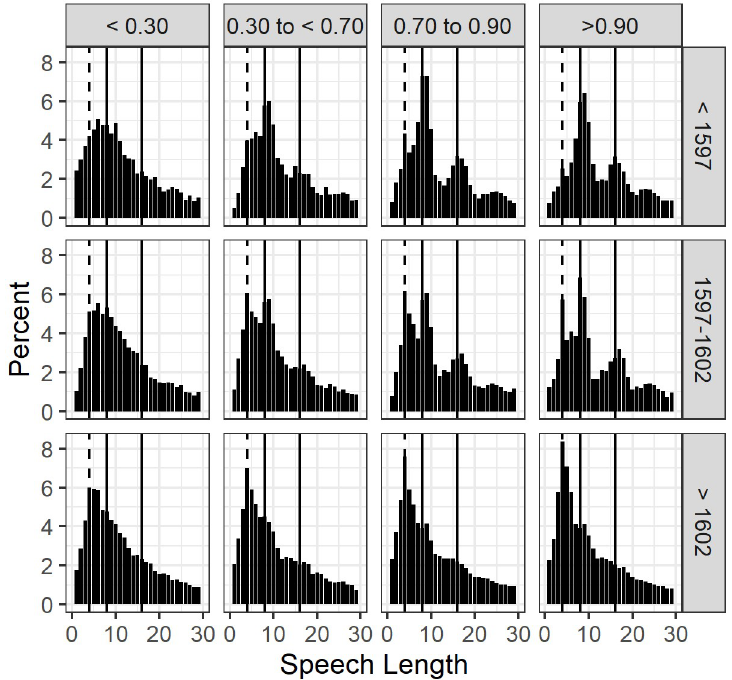
Fig 3. (S1 Fig 4 in S1 File) Distribution of lengths of speeches (the range being from a mode of 1 word to a mode of 30 words) by verse and time period groups. The vertical markers are at speech lengths 4, 8 and 16.